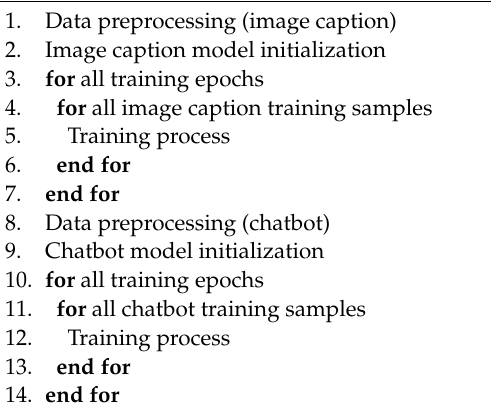
Algorithm 1: The procedure of the proposed